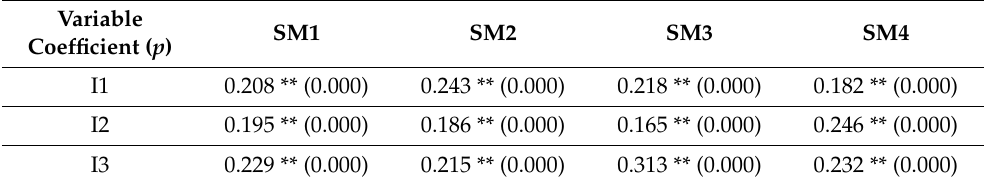
Table 7. ICT vs. Smart Mobility—Pearson correlation results.